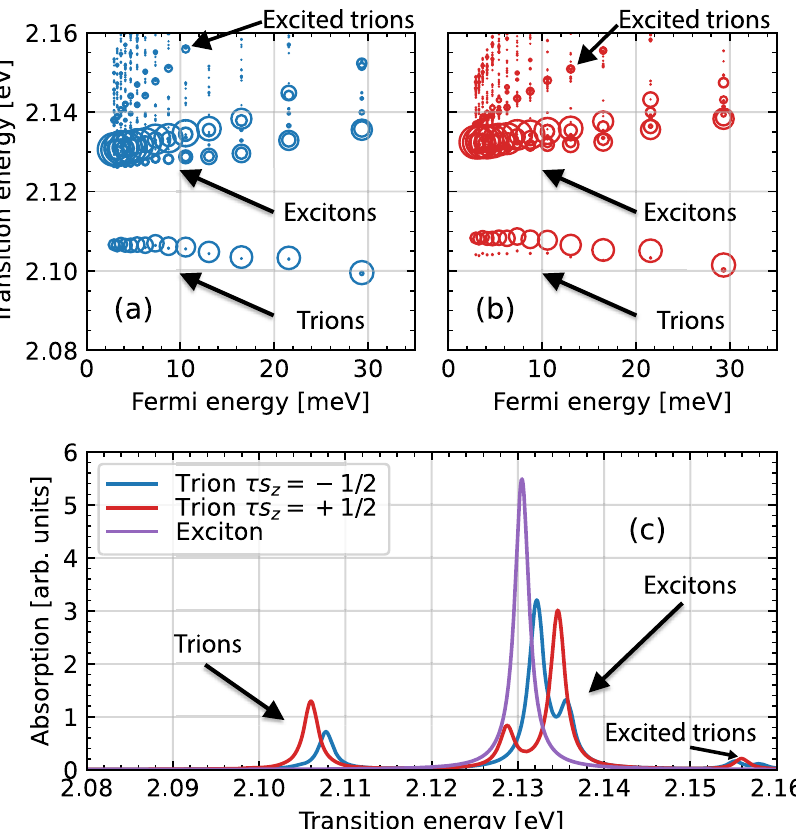
Fig. 2 Trionic and excitonic spectra. a Doping dependence of the transition energy for three-body states shown by blue circle-shaped markers spin-valley index τ s z = − 1/2 and ( b ) by τ s z = + 1/2. The size of each marker is proportional to its optical oscillator strength. We label the emergent modes as excitons, trions, and excited trions. c The absorption spectrum of an MoS 2 monolayer. The purple curve shows the absorption spectrum in the limit of zero doping level, where a single peak corresponds to 1s exciton. The blue curve corresponds to the absorption spectrum of three-particle states with τ s z = − 1/2 at the level of doping equal to E F = 10.56 meV. The red curve shows the same dependence for τ s z = + 1/2 three-particle